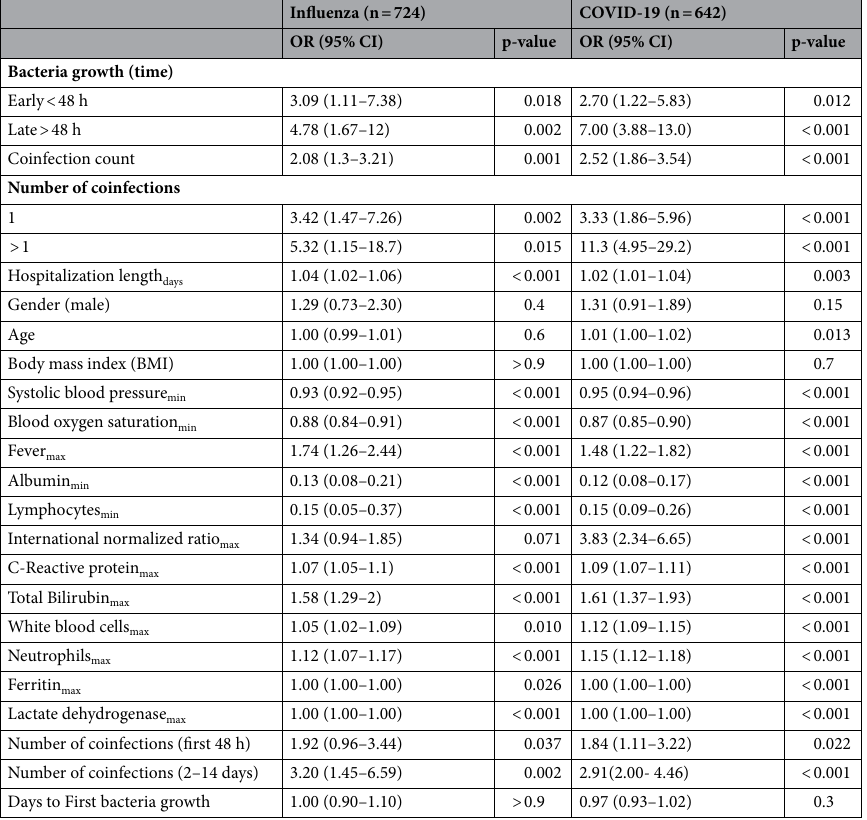
Table 3. Univariate analysis of variables associated with death. OR, odds ratio; CI, confidence interval; min, minimal levels; max, maximal